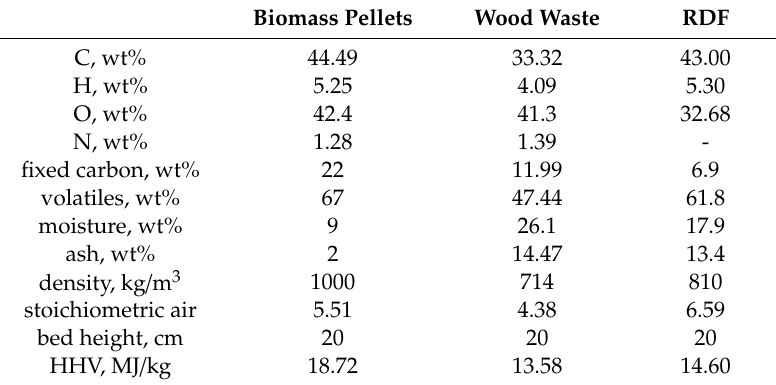
Table 3. Fuel properties (as-received) and stoichiometric air-fuel